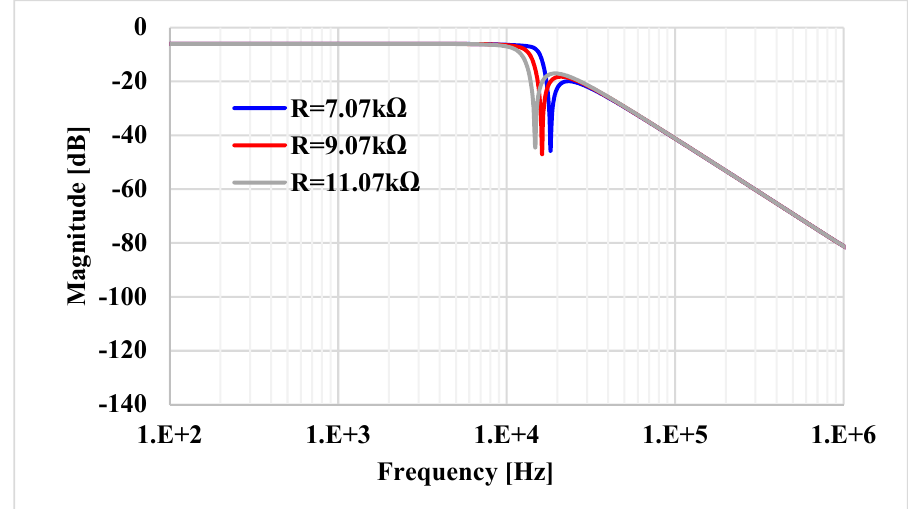
Figure 28. The frequency responses of the LP ladder filter with different R set .